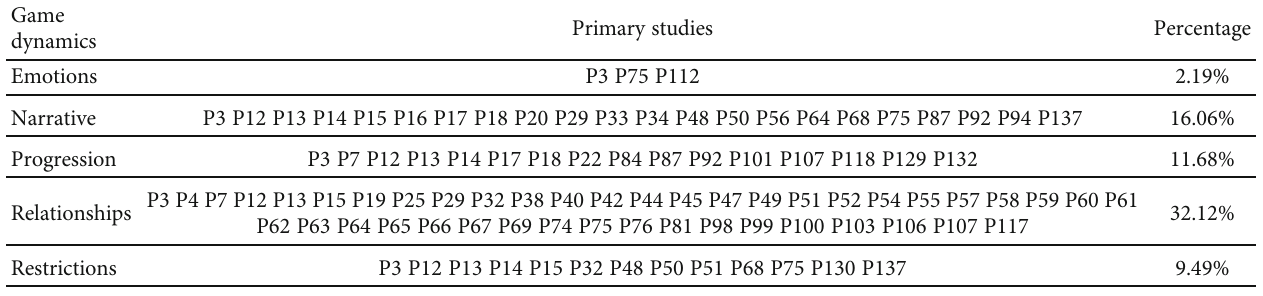
Table 14: Dynamics per primary